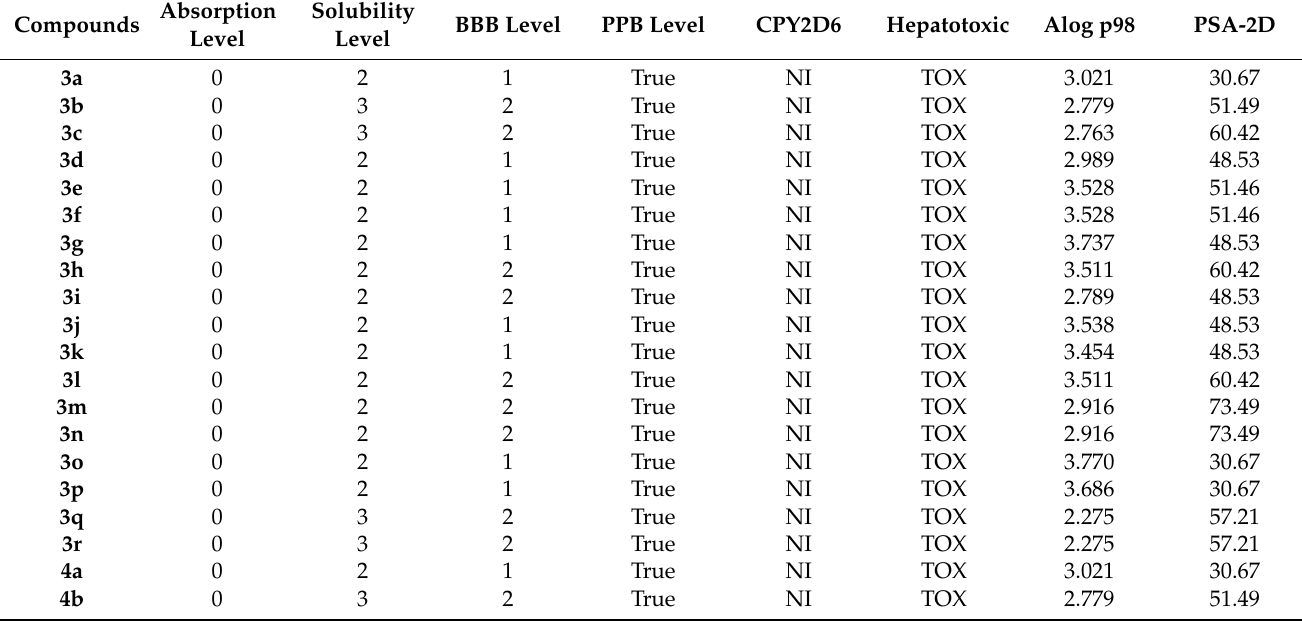
Table 1. ADMET characteristics of the series of synthesized 1-aryltetrahydroisoquinoline derivatives Compounds Absorption Level Solubility Level